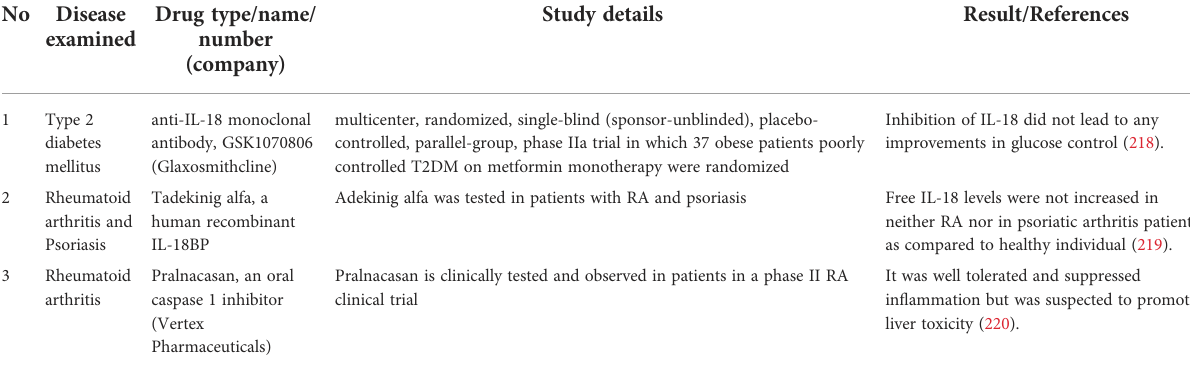
TABLE 3 Some clinical trials targeting IL-18 in the treatment of in fl ammatory diseases. No Disease Drug type/name/ examined